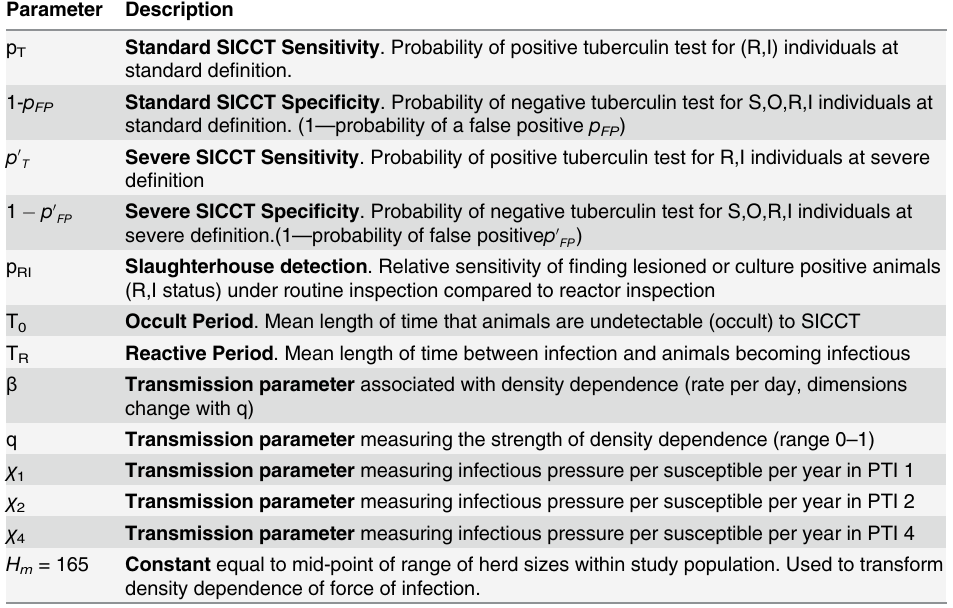
Table 3. Model parameters. Parameter